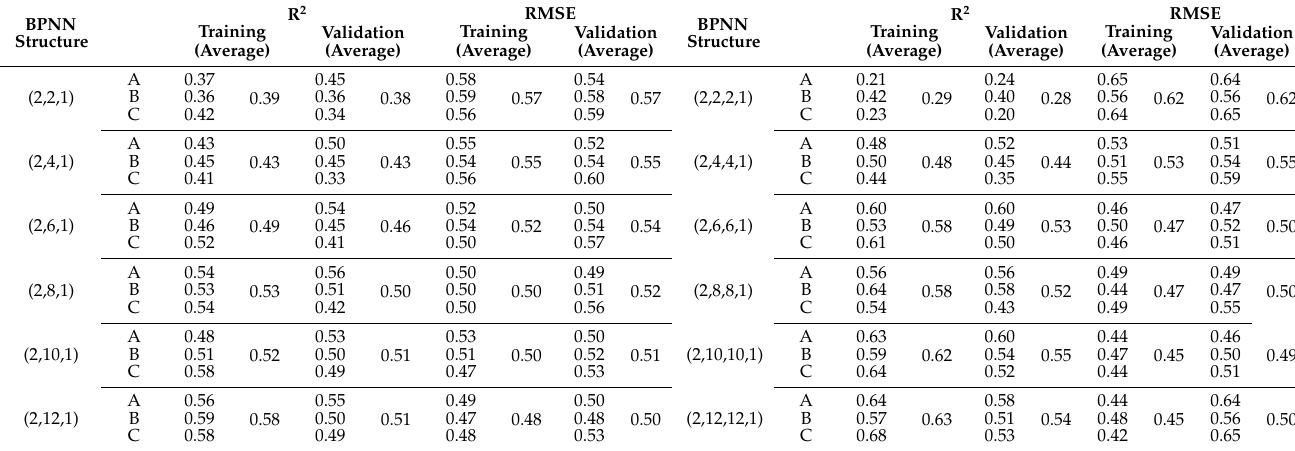
Table 5. Average coefficients of determination (R 2 ) and root mean square error (RMSE) used in each BPNN model. BPNN Structure